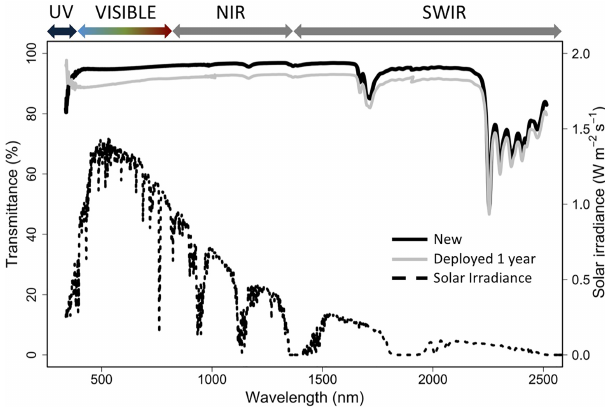
Figure 9. The full shortwave (350 to 2500nm) transmittance of the F-Clean ® film material. The two solid lines depict the measured transmittance through brand-new film (black) and film deployed for 1 full year (grey). To better understand the impact of the film on transmission of solar energy into the ZPW chamber, we also provide the American Society for Testing and Materials (ASTM) Refer- ence Solar Spectral Irradiance for an absolute air mass of 1.5 (black dashed line, http://rredc.nrel.gov/solar/spectra/am1.5/) for the same spectral